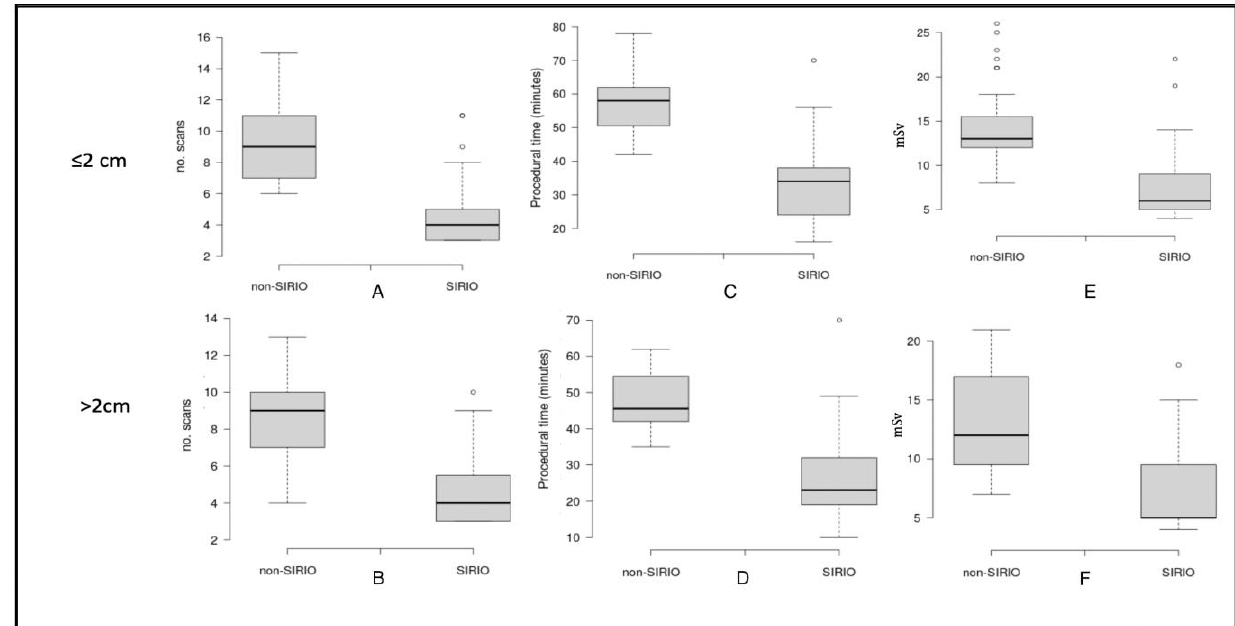
Figure 2. Boxplots showing comparison between mean number of CT-scans ( A , B ), procedural time ( C , D ) and radiation dose ( E , F ) for each group.